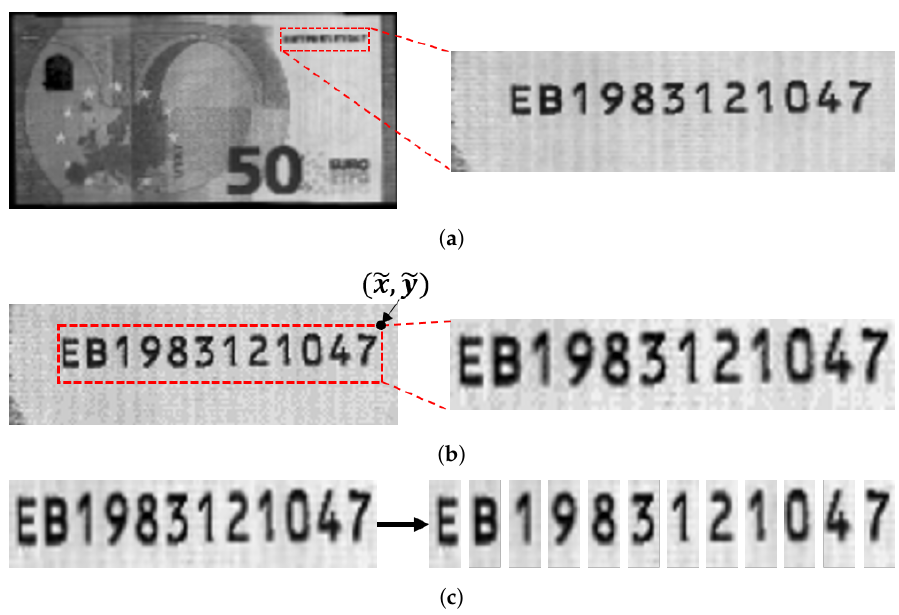
Figure 3. Images of Euro and their cropped image. ( a ) Region detection ( b ) ROI detection ( c ) Character classification.